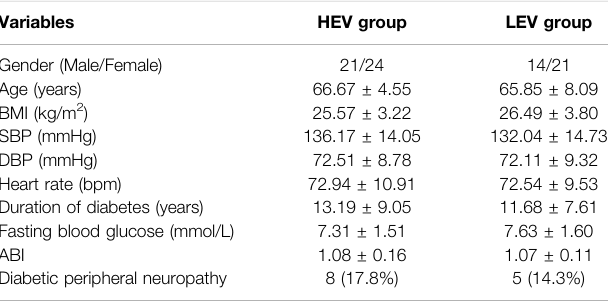
TABLE 1 | Demographic and physiological information of participants in HEV and LEV groups (Mean ± SD).